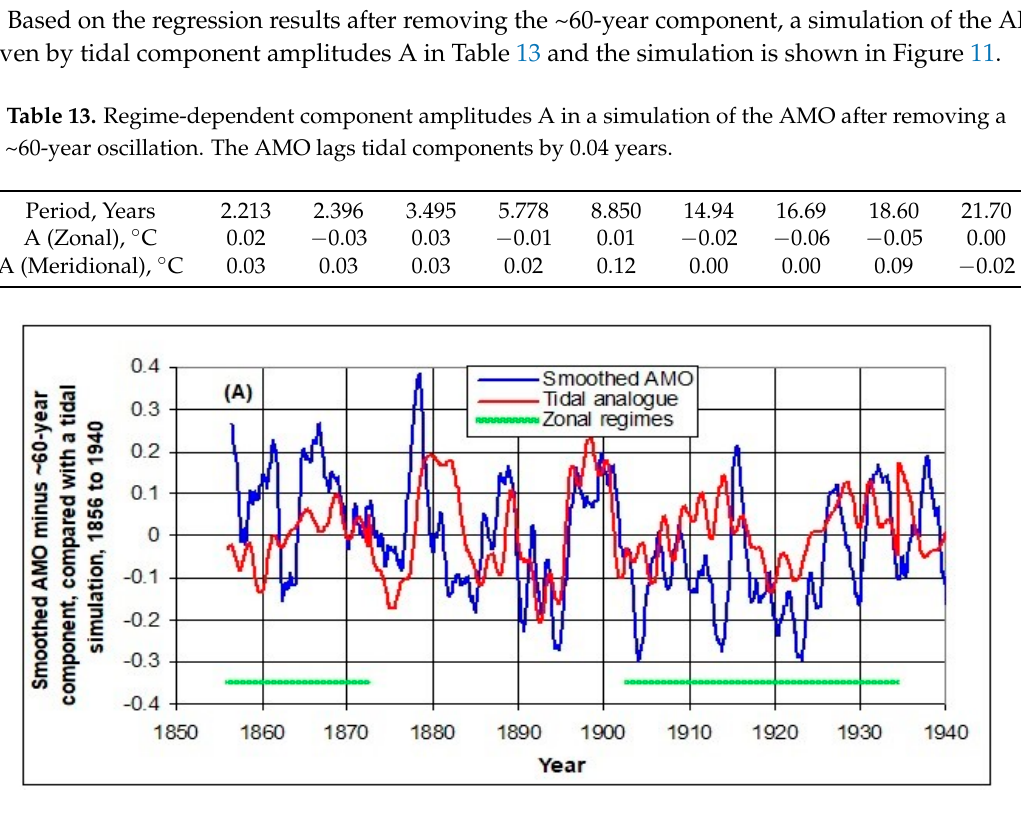
Table 12. Regressions with lag times indicated a lag time of only 0.04 years; whether this is meaningfully